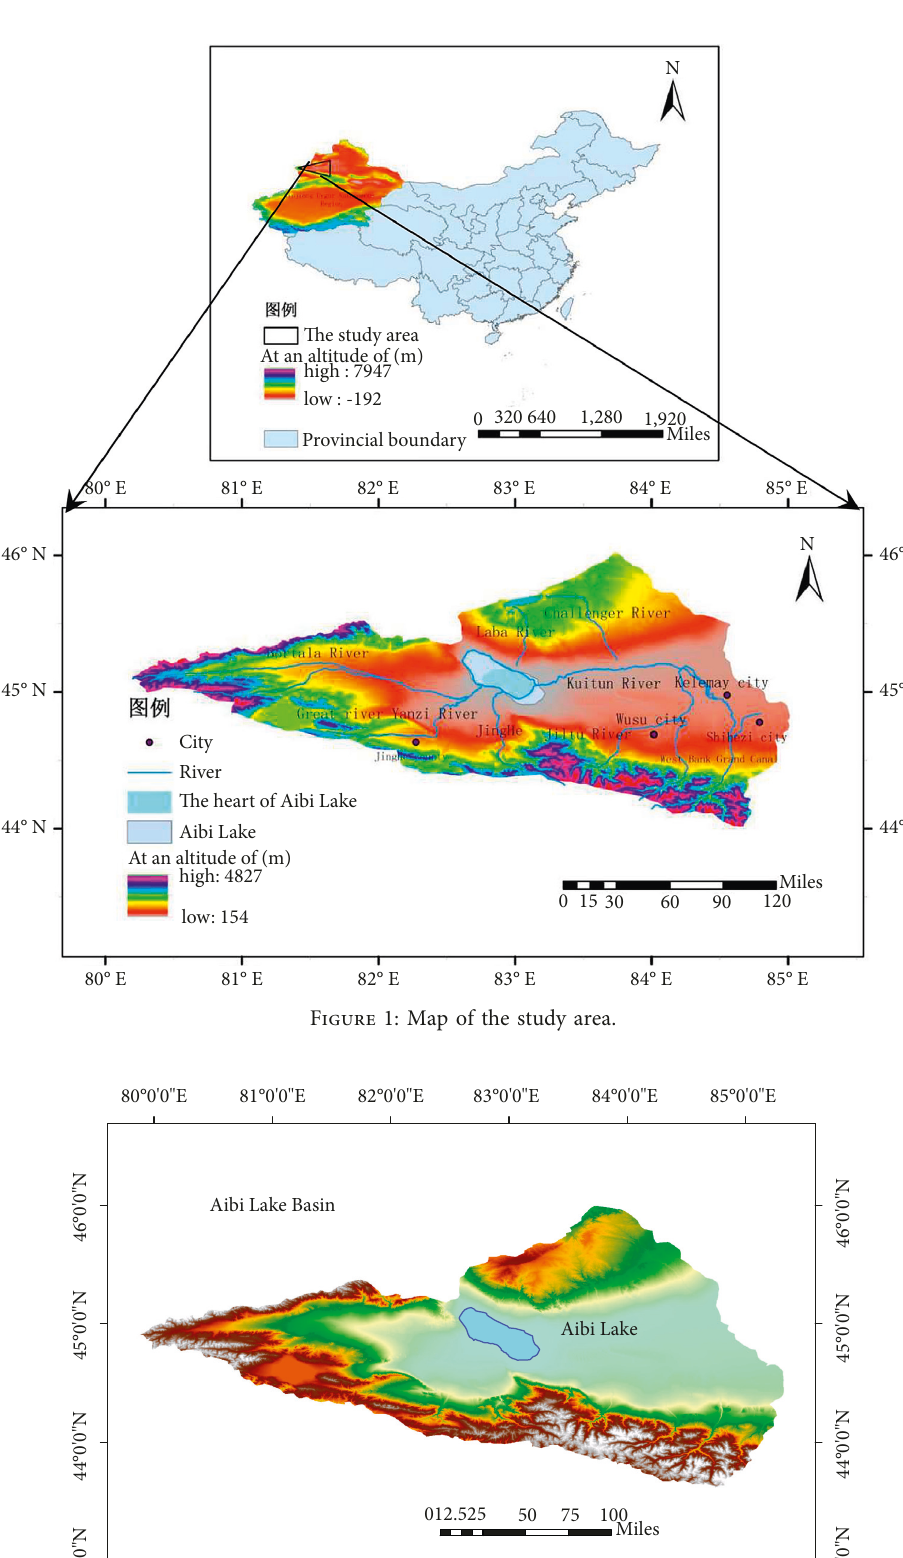
Figure 2: Map of the sampling sites.